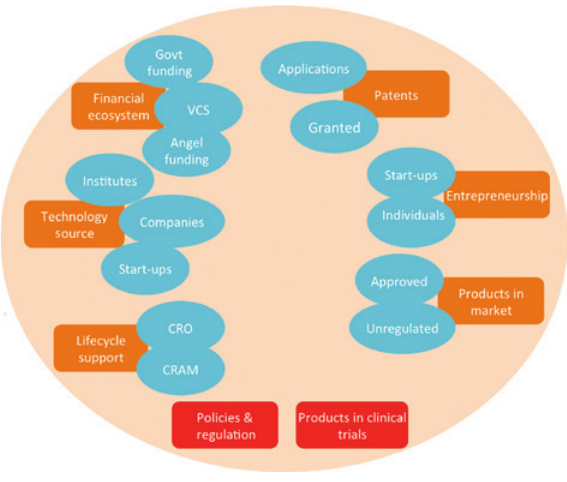
Figure 1: Parameters for the nanomedicine innovation landscape. The various parameters that have been considered in the study to map nanomedicine innovation are financial ecosystem (government funding, venture capitalist, angel funding), technology source (insti- tutes, companies, startups), research translation (life cycle support, products in market, and undergoing clinical trials), bibliometric data (patents and publications), and